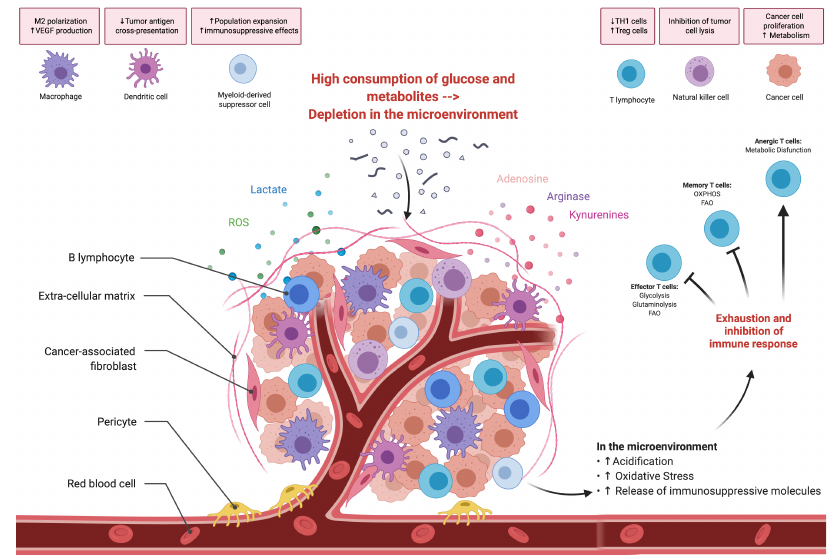
Figure 1. Tumor cell metabolism and immunosuppression. The figure shows the different ways by which the tumor cell metabolic reprogramming conditions the tumor microenvironment and affects the immune response. Treg, regulatory T cells; OXPHOS, oxidative phosphorylation; FAO, fatty acid oxidation; VEGF, vascular endothelial growth factor; ROS, reactive oxygen species, Th1, helper T cells. Created with